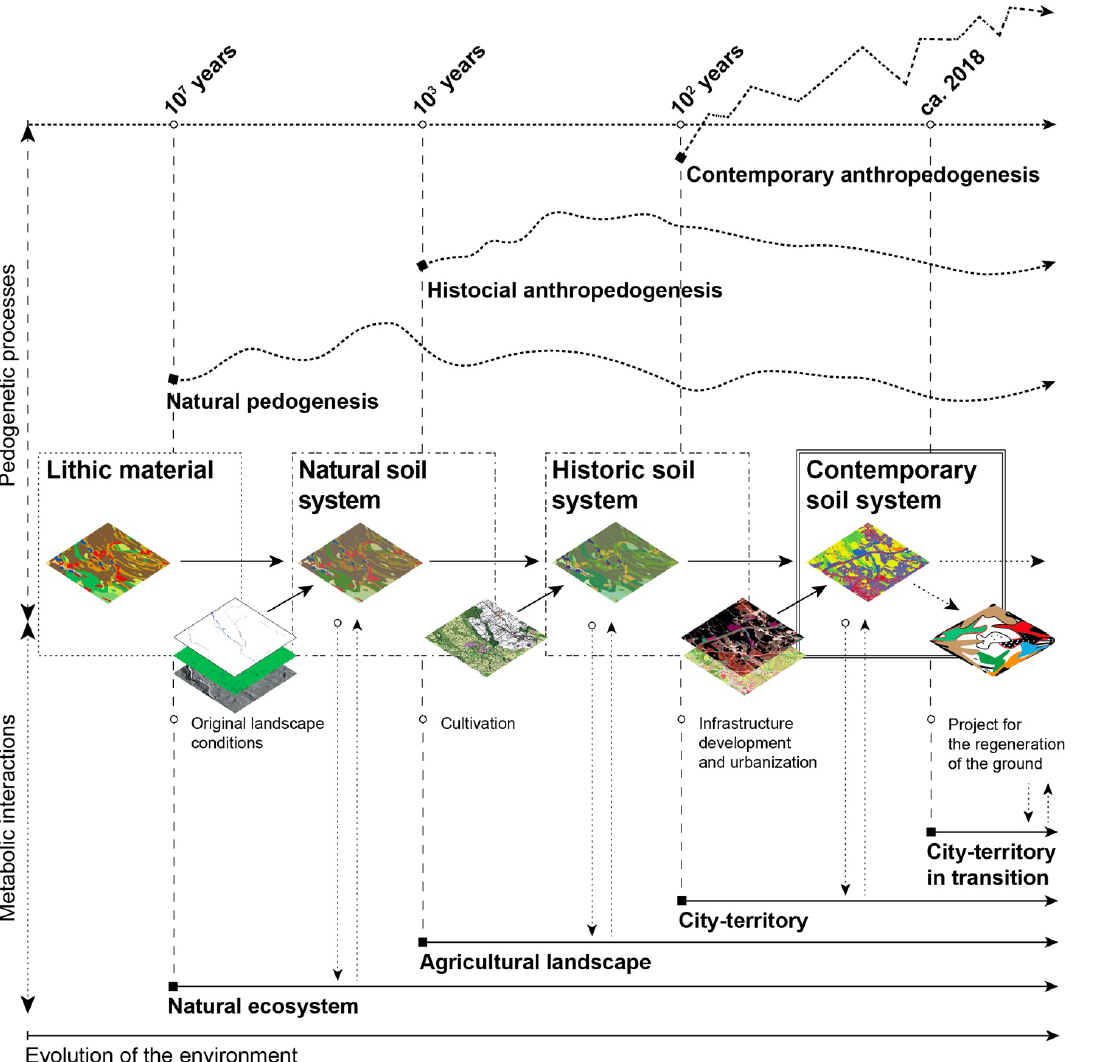
Figure 1. Diagram of human–nature pedogenesis: from top to bottom, coexisting and superimposing time scales, processes of polygenesis, soil systems and corresponding factors, interactions with natural–anthropic environments. Source: Authors, after Yaalon and de Richter